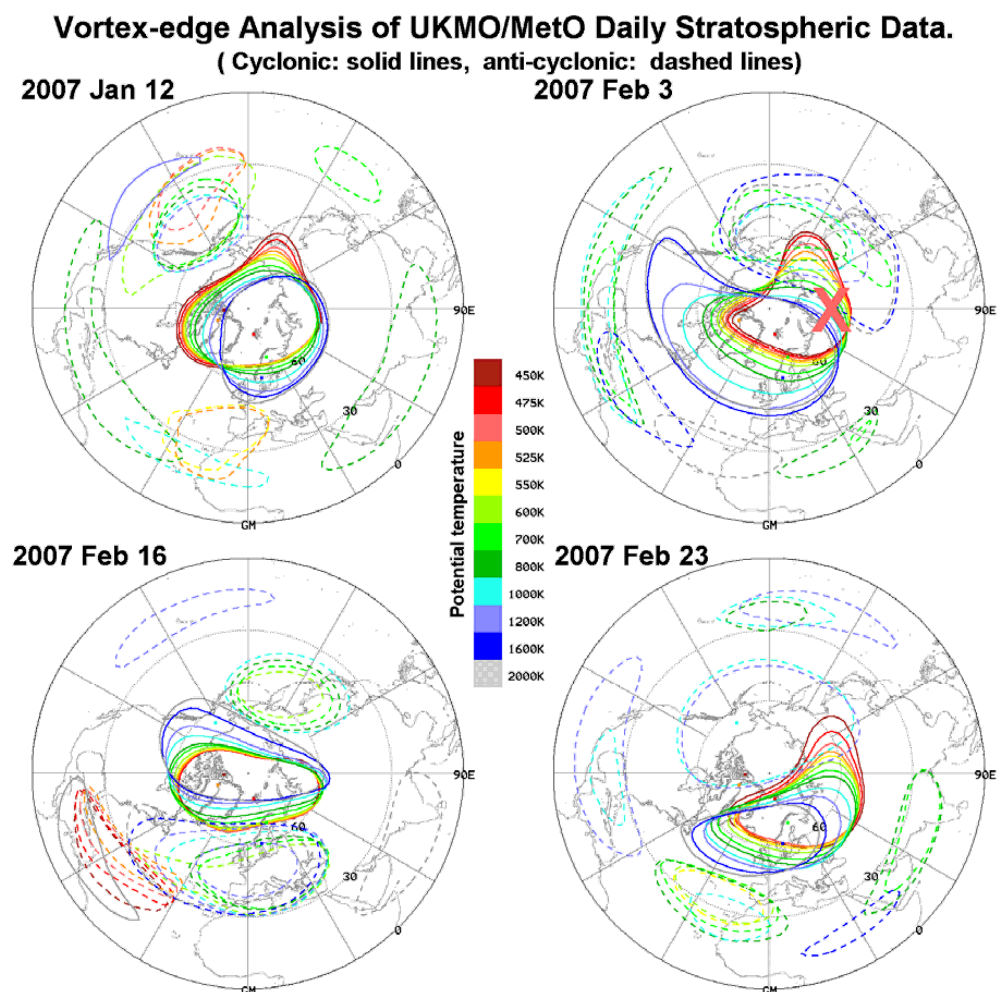
Fig. 4. The polar vortex (solid lines) and anticyclone edges (dashed lines) at 450–2000K isentropic surfaces ( ∼ 20–50km) for 12 January, 3, 16 and 23 February 2007. A “ × ” symbol marks the region with low O 3 mixing ratios near 20km (500K) in the 3 February 2007 vortex.